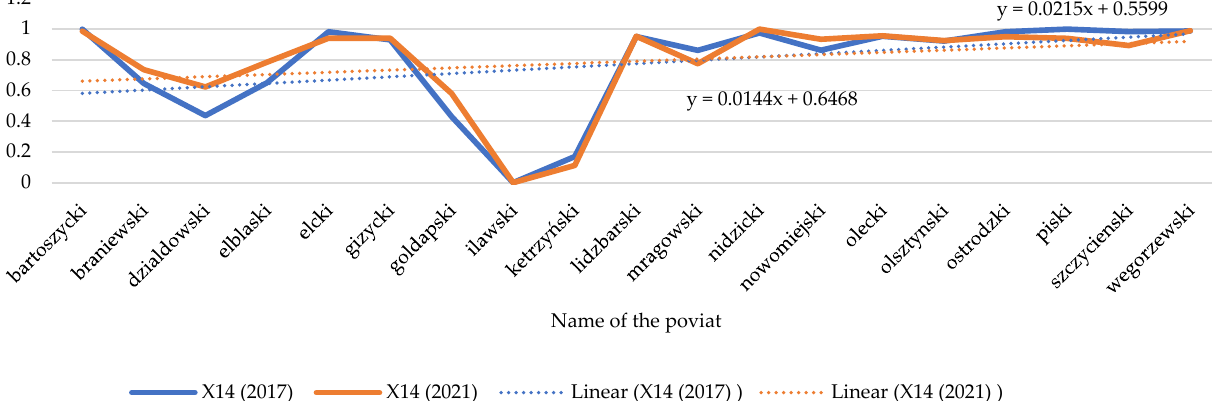
Figure 7. Temporal dynamics of greenhouse gas emissions (X14). Source: own study.